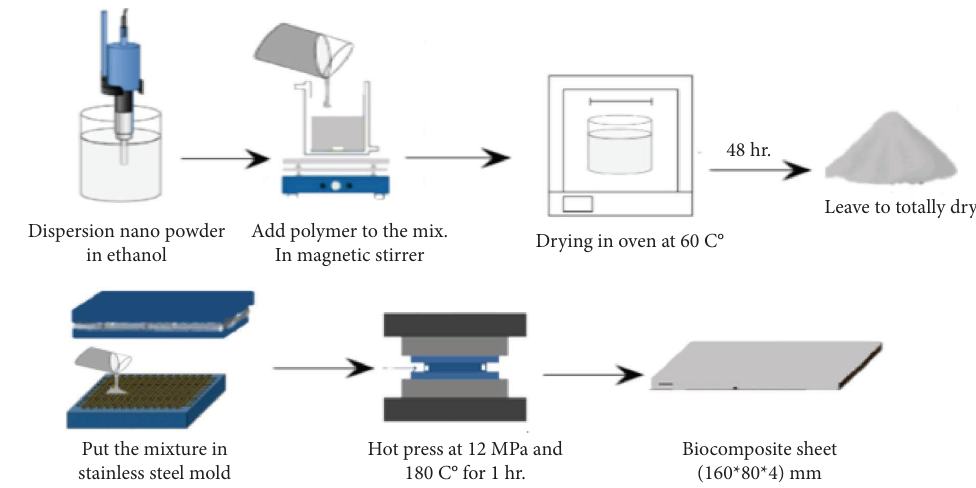
Figure 1: Procedure of manufactured biocomposite materials as bone plate Table 1: DSC results of particulates biocomposite and hybrid biocomposites.